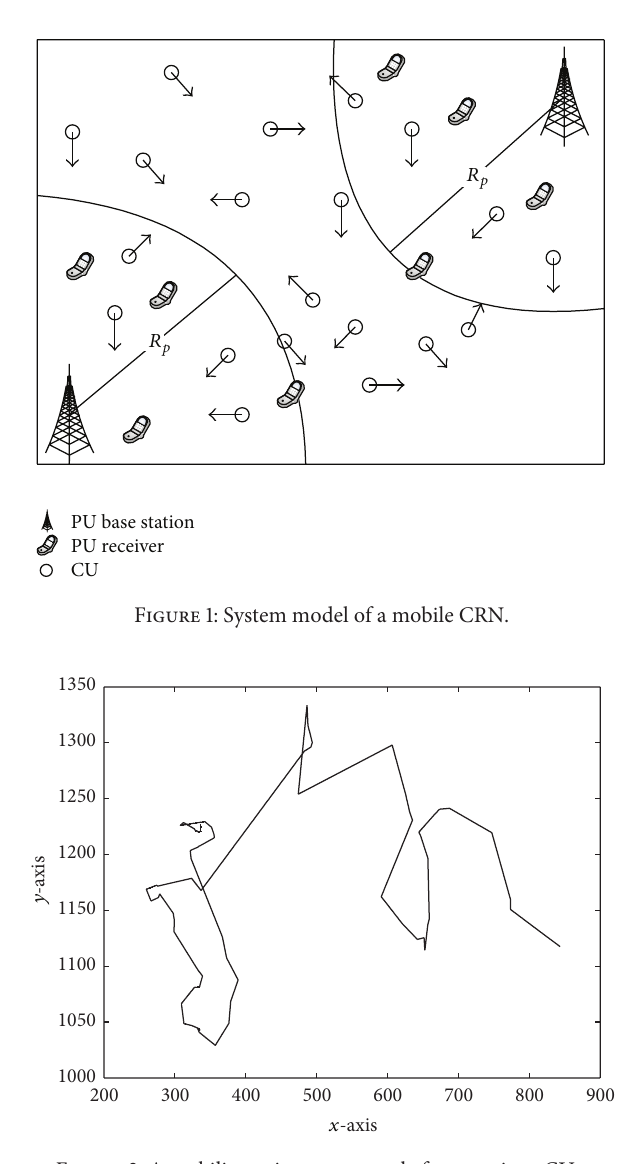
Figure 2: A mobility trajectory example for one given CU 𝑐